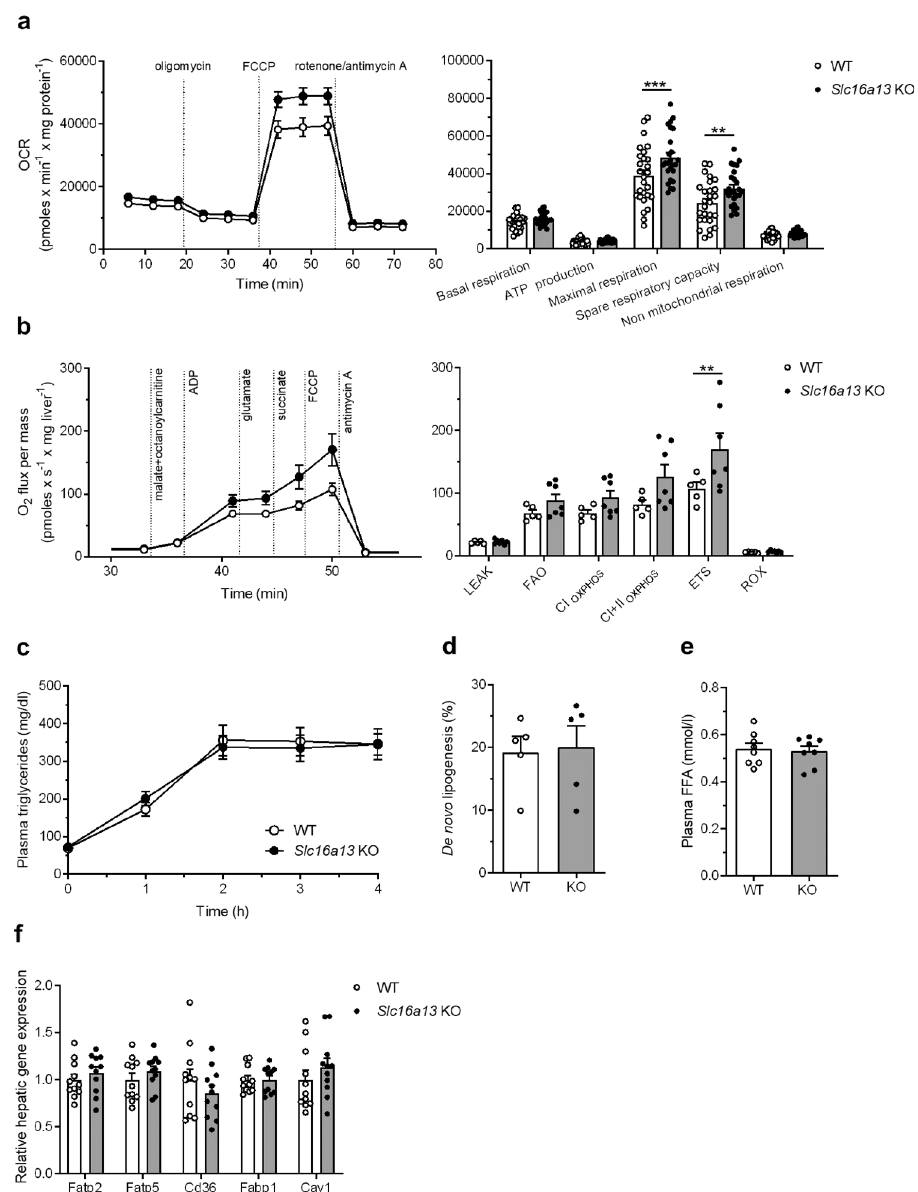
Fig. 8 Mechanisms of reduced hepatic lipid accumulation in Slc16a13 knockout mice. a Mitochondrial respiration of hepatocytes isolated from Slc16a13 WT ( n = 27) and Slc16a13 KO ( n = 25) mice at a mean age of 20 weeks, both groups females fed NCD. Time course and calculated parameters of oxygen consumption rate (OCR) during mitochondrial stress test performed in the Seahorse Analyzer XF96. b Mitochondrial respiration of liver tissue isolated from 20 weeks old HFD-fed Slc16a13 WT ( n = 5) and Slc16a13 KO ( n = 7) mice. Time course and calculated parameters of oxygen fl ux during high- resolution respirometry performed in the Oroboros Oxygraph-2k. LEAK = proton leak, ion leak, and slip compensatory state; FAO = fatty acid oxidation; OXPHOS = oxidative phosphorylation; CI OXPHOS = complex I-related oxidative phosphorylation capacity; CI + II OXPHOS = complex I and II-related oxidative phosphorylation capacity; ETS = electron transfer system; ROX = residual oxygen consumption. c Plasma triglyceride levels after intraperitoneal injection of the LPL-inhibitor Poloxamer-407 at an age of 18 weeks. d Hepatic de novo lipogenesis in WT and Slc16a13 KO mice at 20 weeks of age. e Plasma level of free-fatty acids (FFA) in a fasted state. f Relative hepatic mRNA expression of fatty acid transporters. Slc16a13 WT ( n = 5 – 11), Slc16a13 KO ( n = 5 – 11). a – c Means ± SEM are displayed. a , b , d – f Bars represent means ± SEM. ** p < 0.01, *** p < 0.001 determined using two-way ANOVA followed by Sidak ’ s multiple comparison